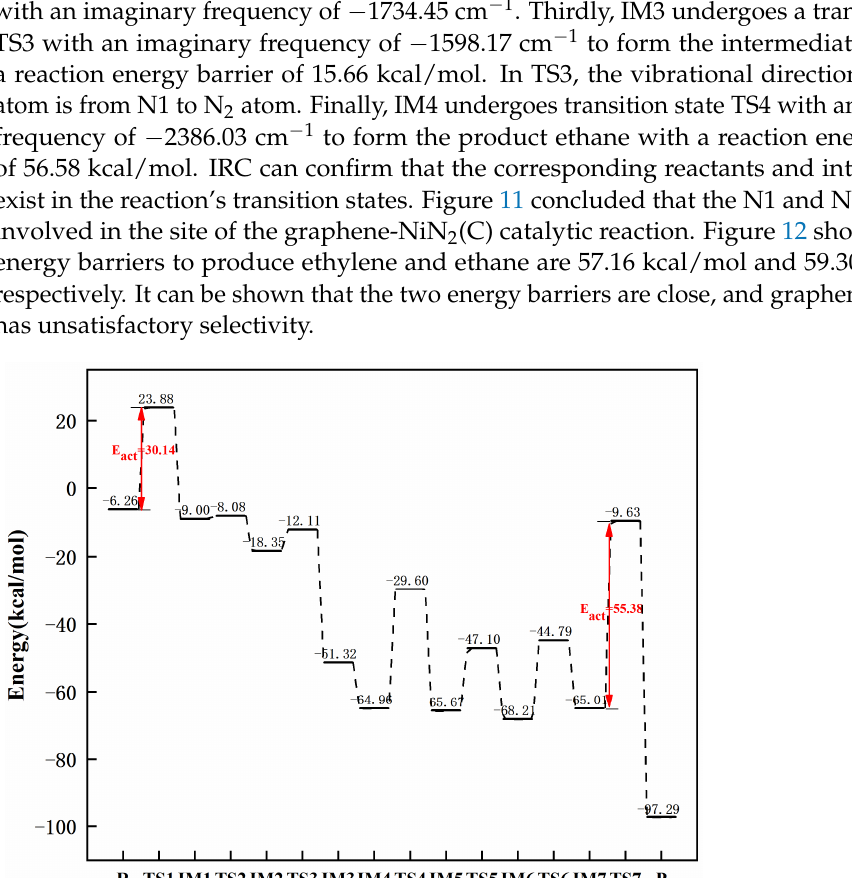
Figure 8. The most favorable energy path diagram for the hydrogenation of acetylene on graphene- NiN 2 (A).